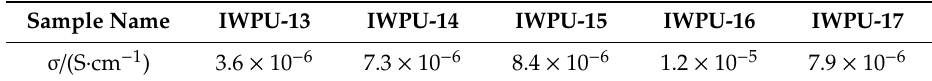
Figure 6. Ionic conductivity results of the IWPU films. Table 7. Ionic conductivity values of IWPU films.